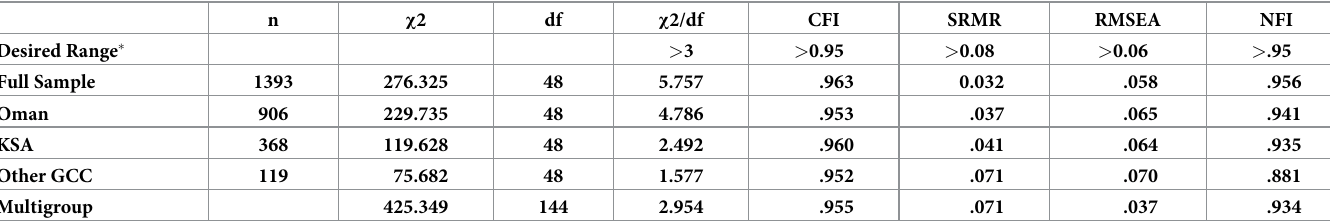
Table 6. Goodness of fit statistics of SPANE